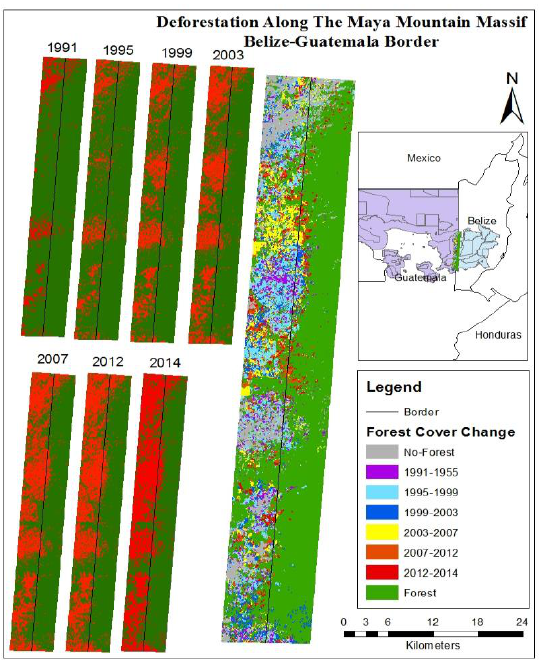
Figure 3. Deforestation along the Belize-Guatemala western border 1991-2014 However, the highest deforestation rates occurred from 1995- 1999 with a loss of -2.9% annual reduction and 2012-2014 with a -2.7% annual reduction of forested area. The lowest deforestation rates occurred between 1991-1995 and 2007- 2012, both with -1.1% forest loss. Figure 4 illustrates that the Forest Total and Forest Gua curves follow a similar slope in both forested and non-forest areas. On the other hand, Forest Bz and No-Forest Bz slope vary, indicating lower deforestation.